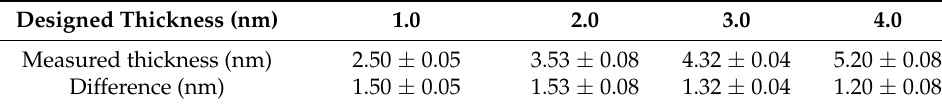
Table 1. The thickness of Al 2 O 3 film measured using the